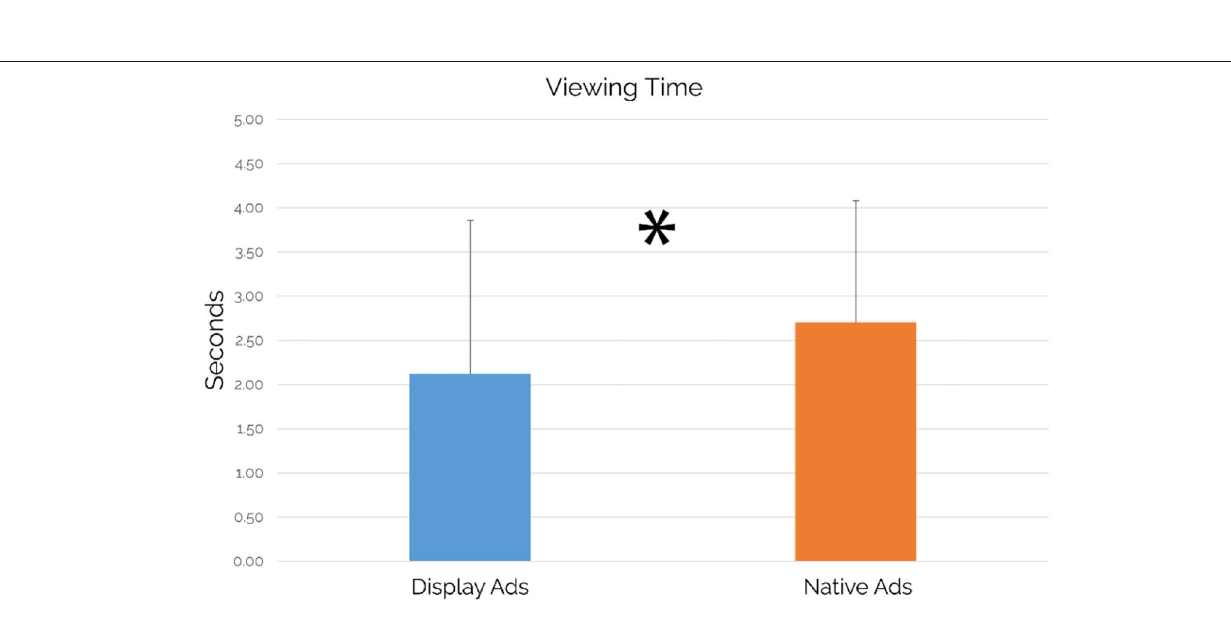
FIGURE 6 | Viewing time: comparison between the display and native ads ( n = 49). Native ads showed a statistically significant increase in Viewing time values in comparison to display ads ( p = 0.041, d = 0.31). Error bars represent standard